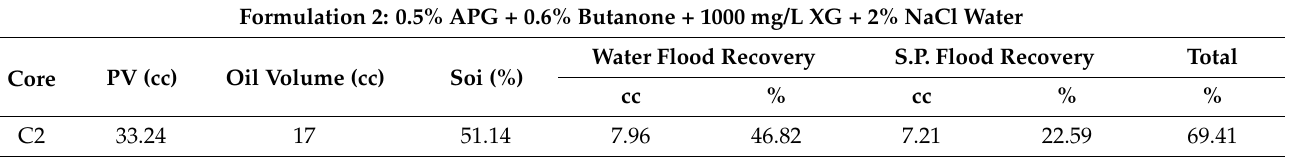
Table 7. Flood results for butanone, APG 264, and Xanthan gum mixture.